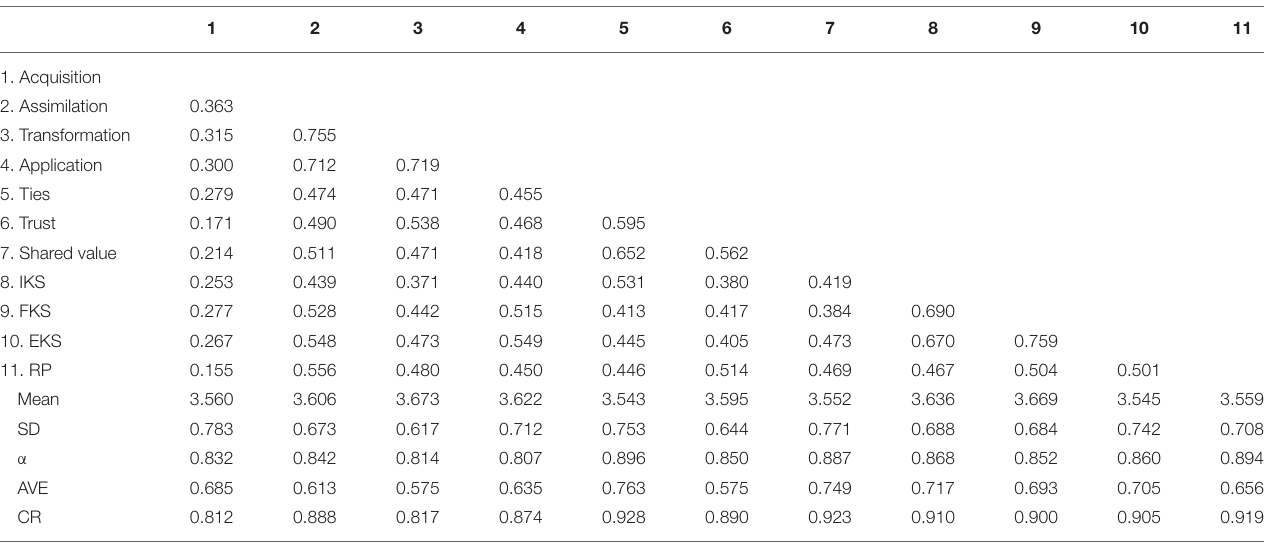
TABLE 1 | Verification of measurement model.